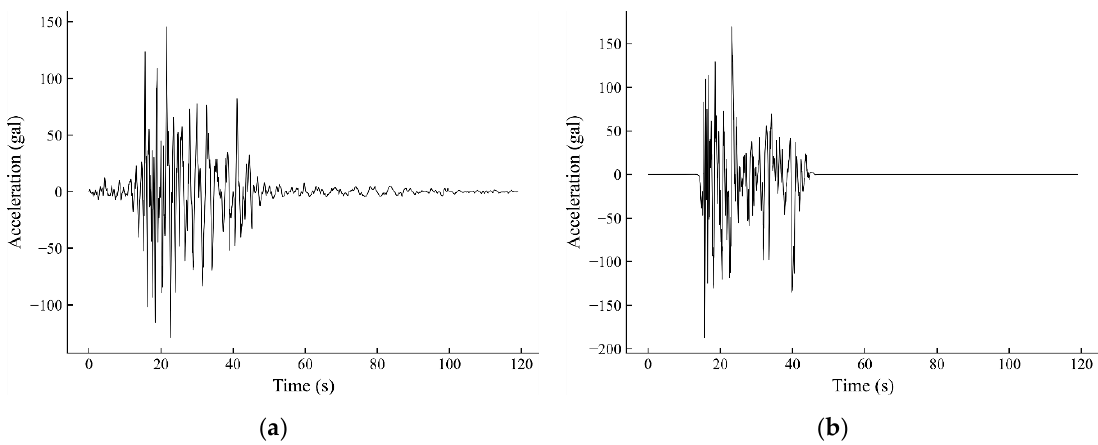
Figure 4. Random disturbance generated by ( a ) Shannon wavelets and ( b ) Gabor wavelets.